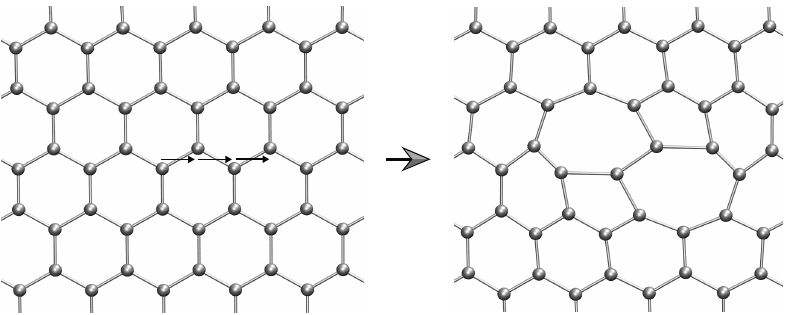
Figure 4. Unrelaxed Stone-Wales defect configuration generated by gliding along three consecutive zig-zag bonds.